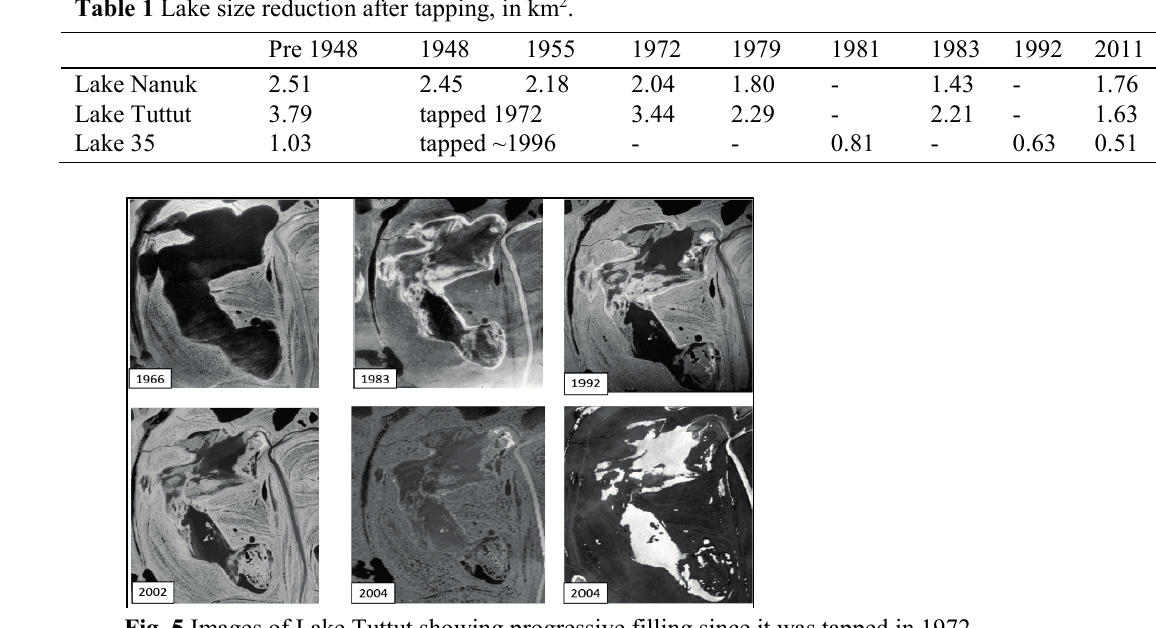
Fig. 5 Images of Lake Tuttut showing progressive filling since it was tapped in